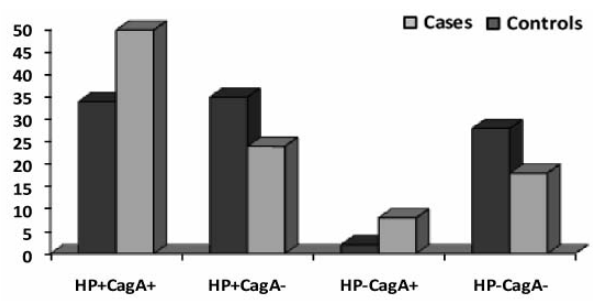
Figure 2. Distribution of combination patterns of H. pylori and cytotoxin associated gene A seropositivity in controls and patients.